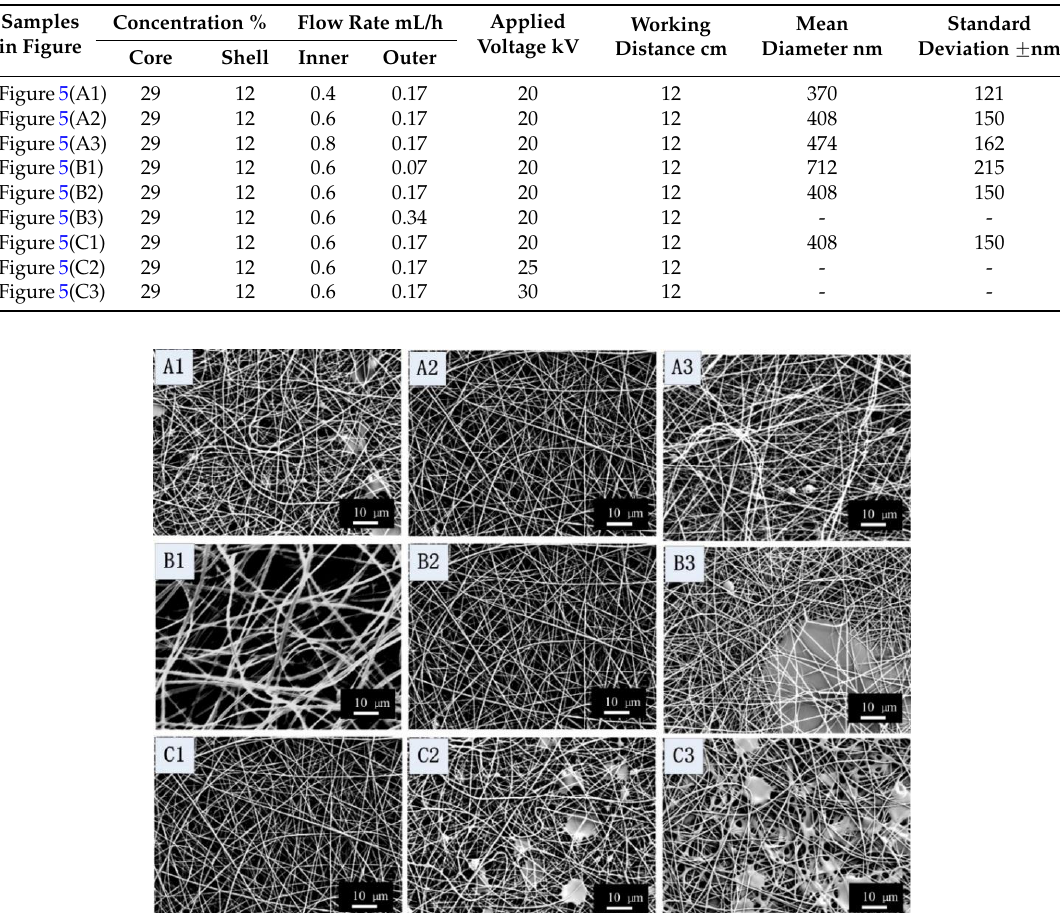
Figure 5. SEM images of coaxial electrospun SF-SELP nanofibers at different processes parameters: ( A1 , A2 , A3 ) inner flow rates at 0.2, 0.4, and 0.6 mL/h, respectively; ( B1 , B2 , B3 ) outer flow rates at 0.07, 0.17, and 0.34 mL/h, respectively; ( C1 , C2 , C3 ) applied voltage at 20, 25, 30 kV, respectively. Other processing parameters are listed in Table 2.